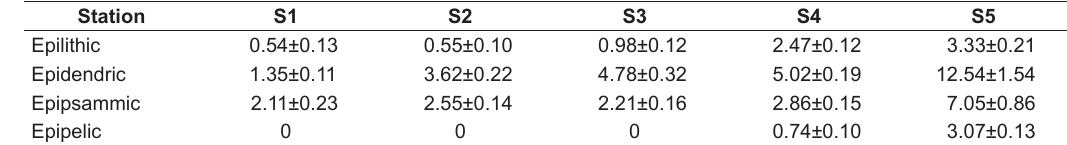
Table 2. Relative abundance (mean ± SD) of P. laevis on different substrata at five sampling